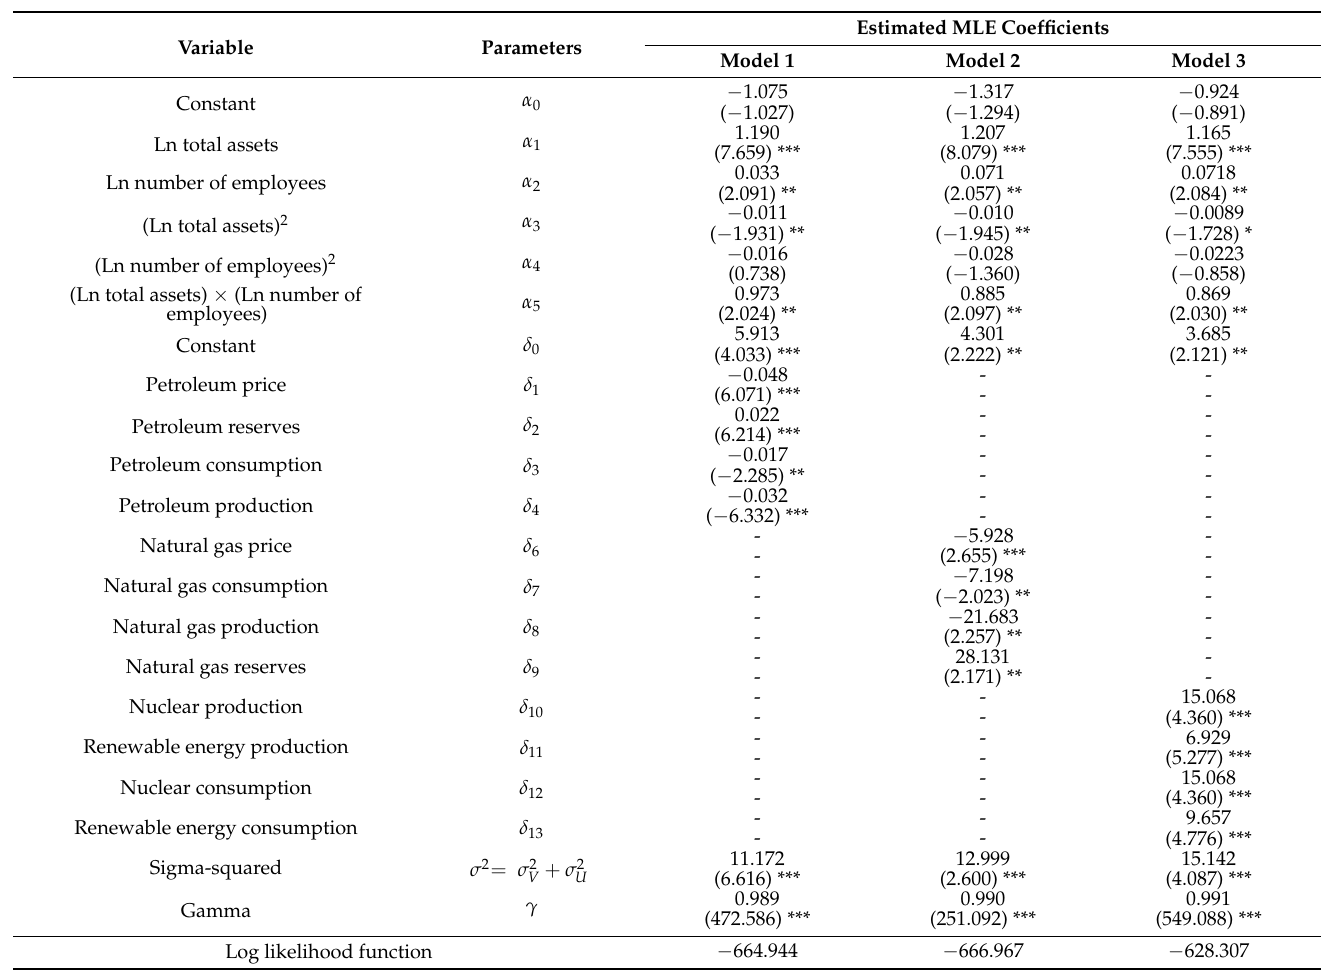
Table 2. Estimated parameters of the translog SFA production